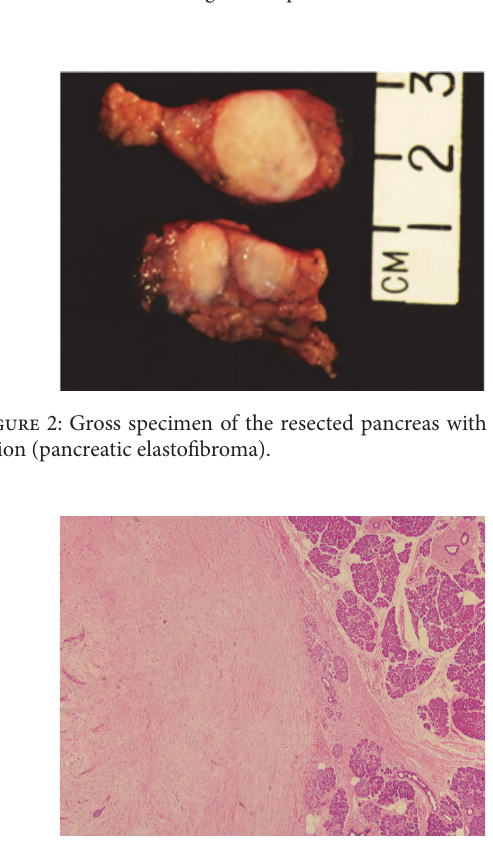
Figure 1: EUS image of the pancreatic elastofibroma.